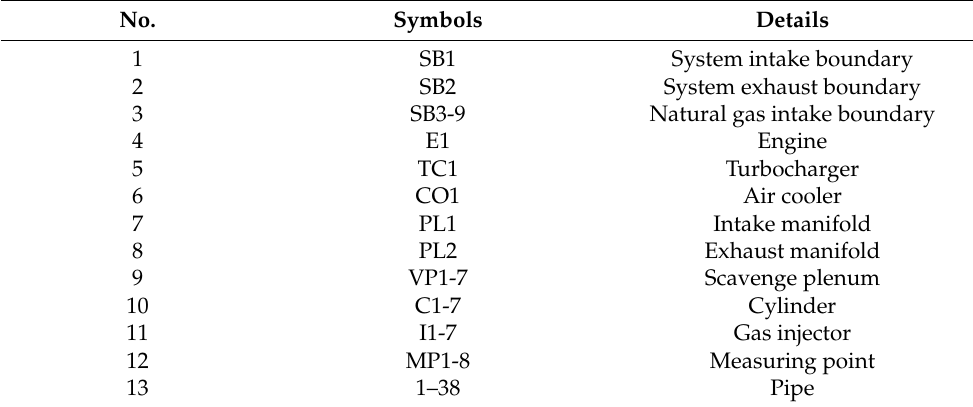
Table 2. The main definitions of the symbols.